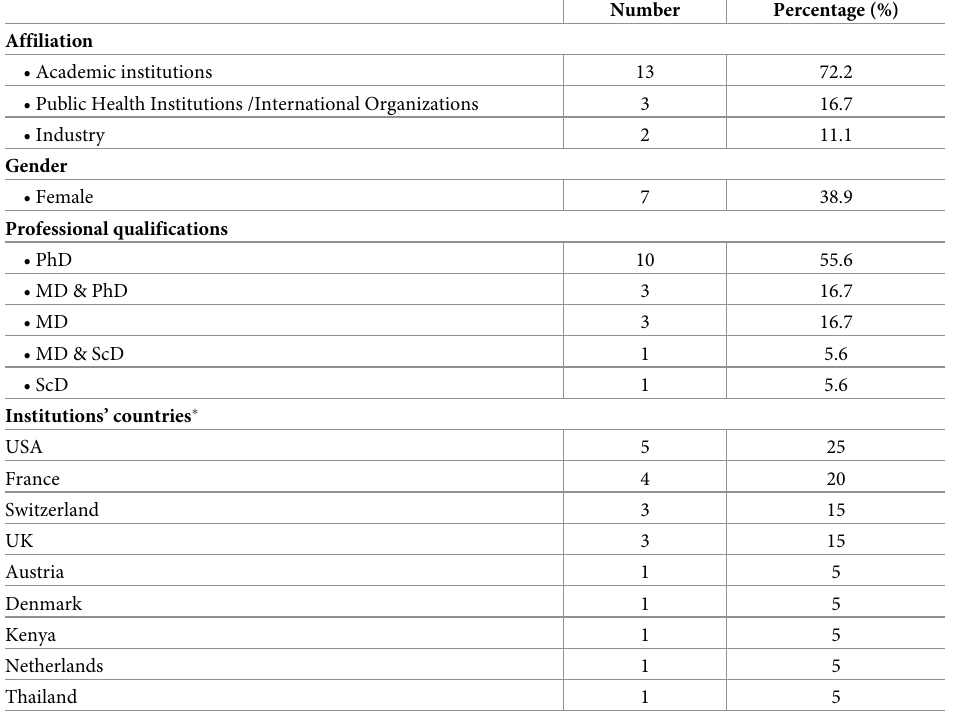
Table 2. Participants’